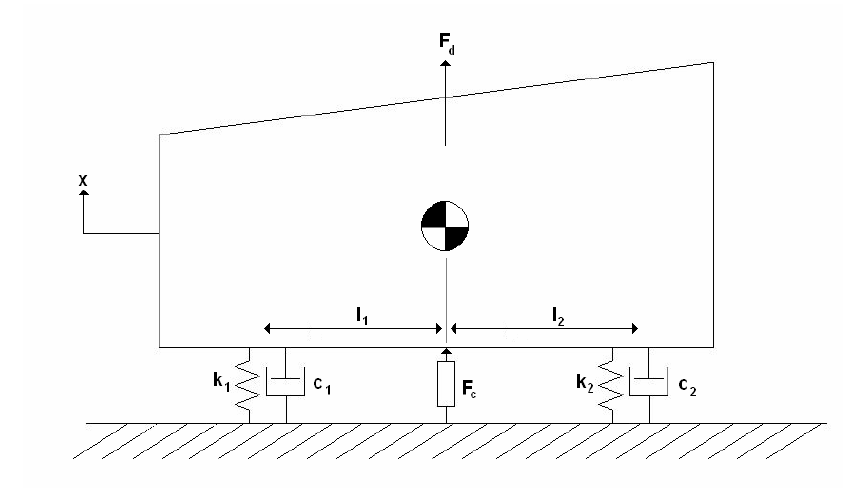
Fig. 11. A schematic diagram of an engine vibration